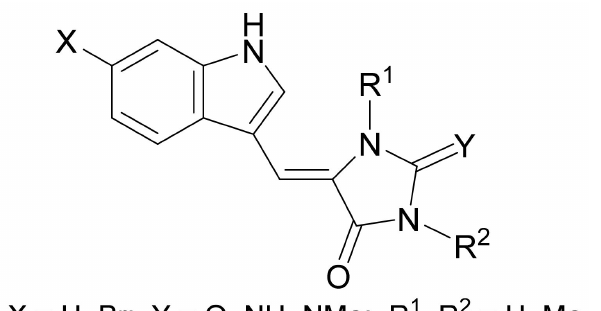
Figure 3. General formula of